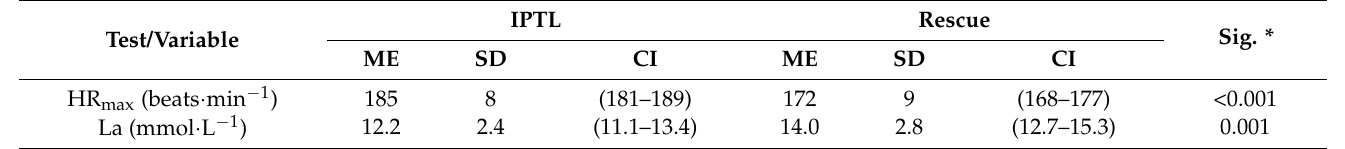
Table 4. Analysis of the differences observed between the IPTL and the rescue.